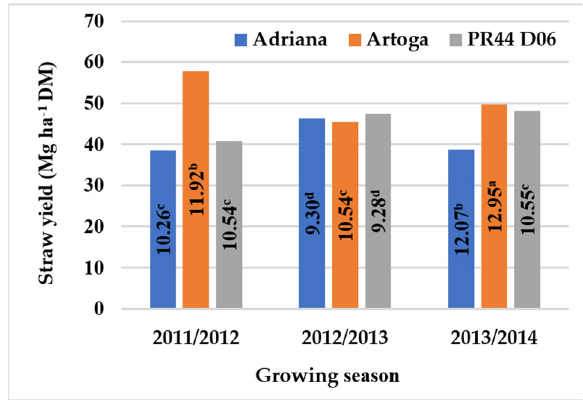
Figure 6. Straw yield of winter oilseed rape cultivars, across growing seasons (2011–2014). Means with the same letters do not differ significantly at p ≤ 0.05 in Tukey`s test. Energies 2020 , 13 , 4654